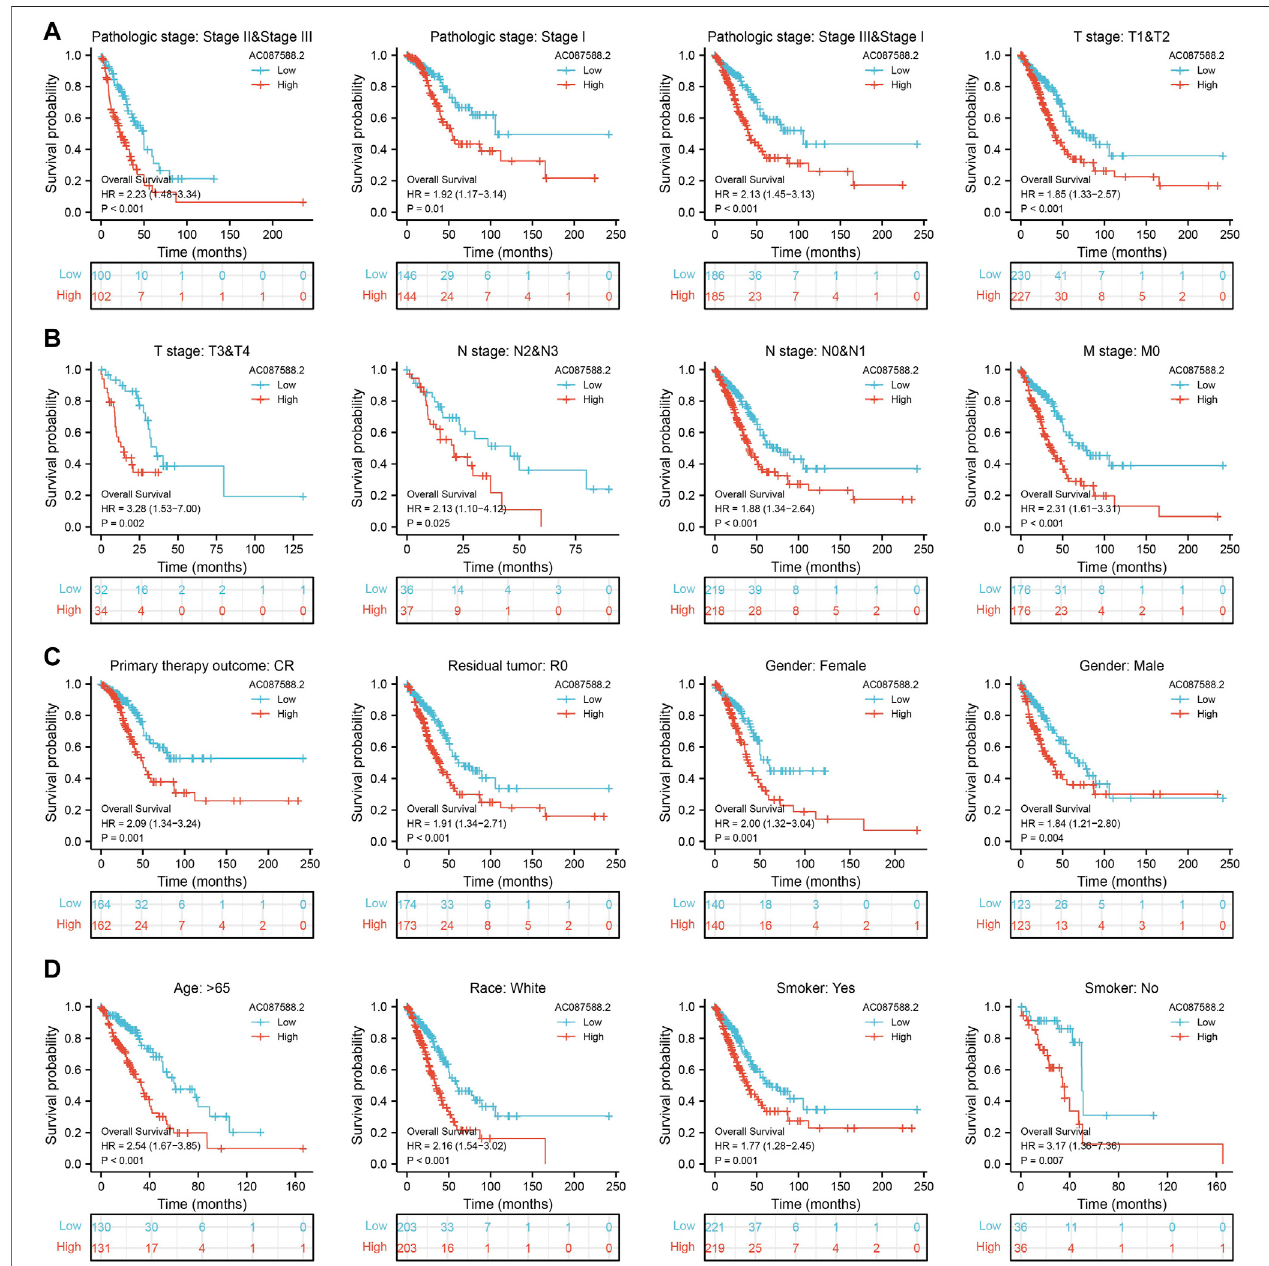
FIGURE4| OverallsurvivalofAC087588.2basedonthediversesubgroup. (A – D) OverallsurvivalofAC087588.2basedonthediversesubgroup,includingstages II and III, stage I, stages I and III, T1 and T2, T3 and T4, N0 and N1, N2 and N3, M0, primary: CR, R0, female, male, age > 65, smoker.